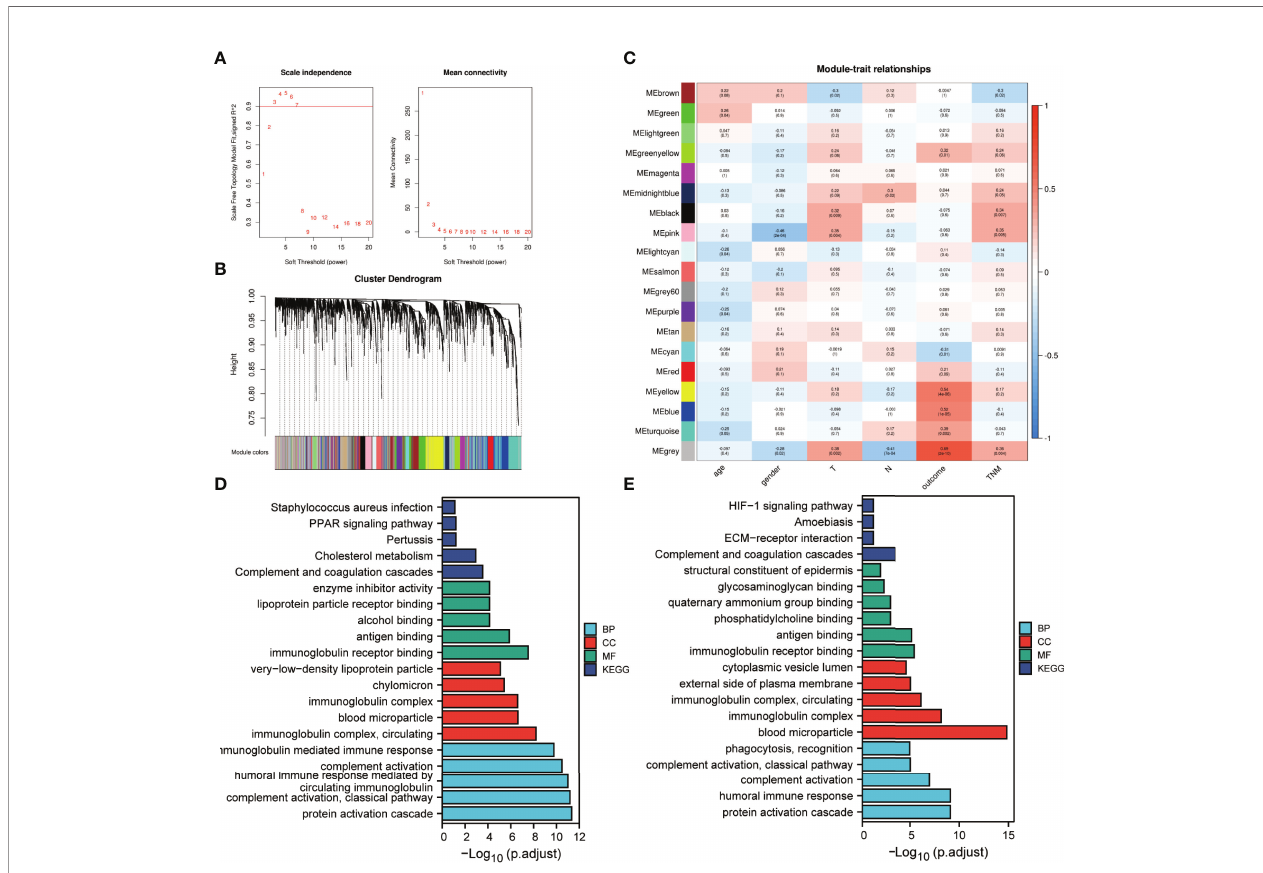
FIGURE 6 | Protein modules associated with the clinical traits of LA-NPC identi fi ed by weighted gene co-expression network analysis (WGCNA). (A) Analysis of scale-free index and mean connectivity for various soft-threshold powers. (B) Dendrogram of all identi fi ed proteins clustered based on dissimilarity through consensus topological overlap with the corresponding module. Coloured rows correspond to the 19 modules identi fi ed. (C) Heatmap of correlations between module eigen proteins and clinical traits of LA-NPC. (D) Functional enrichment analysis of proteins in modules associated with tumour stage. (E) Functional enrichment analysis of proteins in modules associated with IC